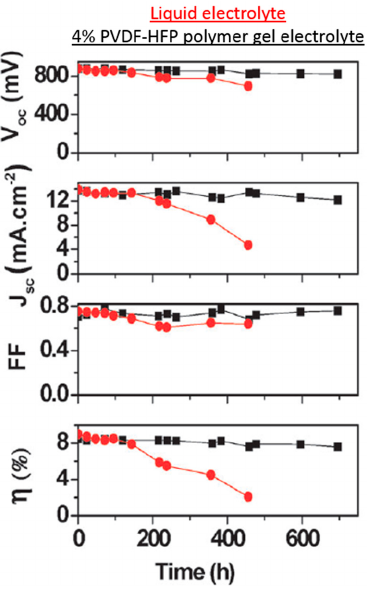
Figure 6. Stability test of liquid ‐ and polymer gel electrolyte ‐ based DSCs under one sun continuous illumination. Adapted and reprinted with permission from [80].